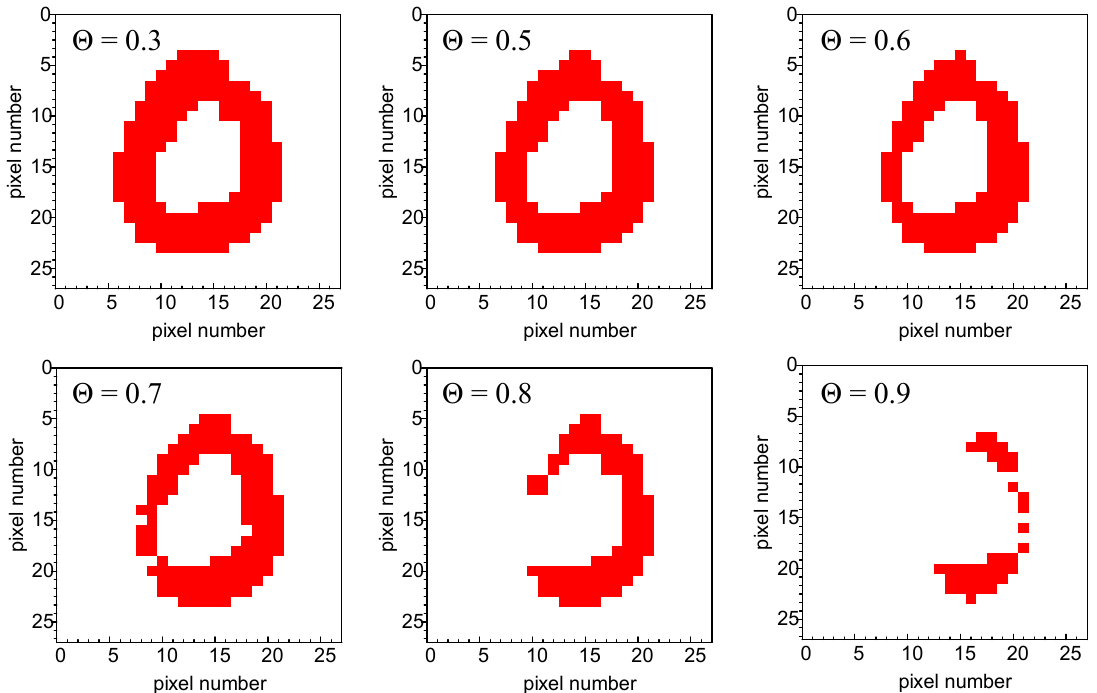
Figure 8. An image of the character from Figure 7 reconstructed from the normalized photocurrent spikes at different threshold values. Table 2. The collection of separability indices for the output data in κ 1 , κ 2 , κ 3 projection at the threshold Θ = 0.7. The efficiency of data separation is color coded from red (no separation, ξ = 0) to green (perfect separation, ξ = 1).